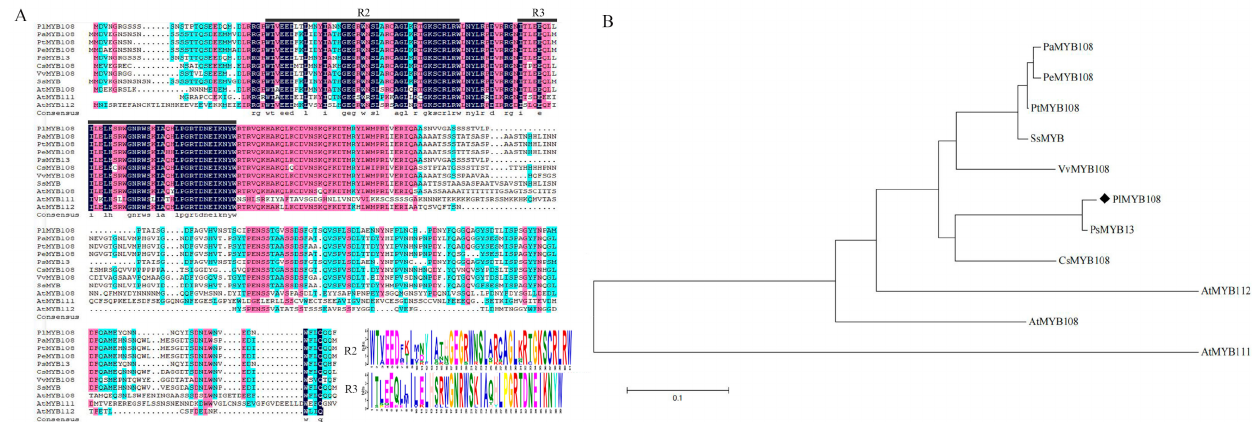
Figure 2. Sequences alignment and phylogenetic tree of PlMYB108 and seven other MYB proteins from plants. ( A ) Sequences alignment. The R2 and R3 MYB domains shown refer to two repeats of the MYB DNA-binding domain of MYB proteins. ( B ) Phylogenetic tree. Protein accession numbers are as follows: Populus alba MYB108 (XP_034907007), Populus